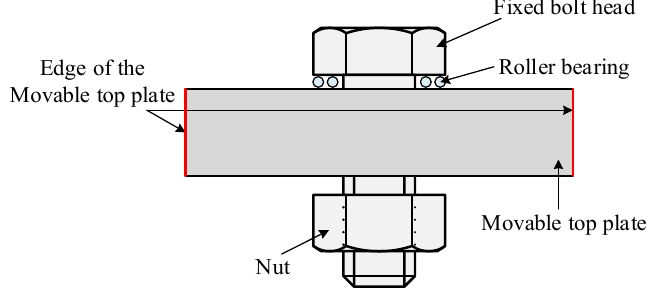
Figure 6. The detailed 3D model of the bolted connection described in Ref. [48].